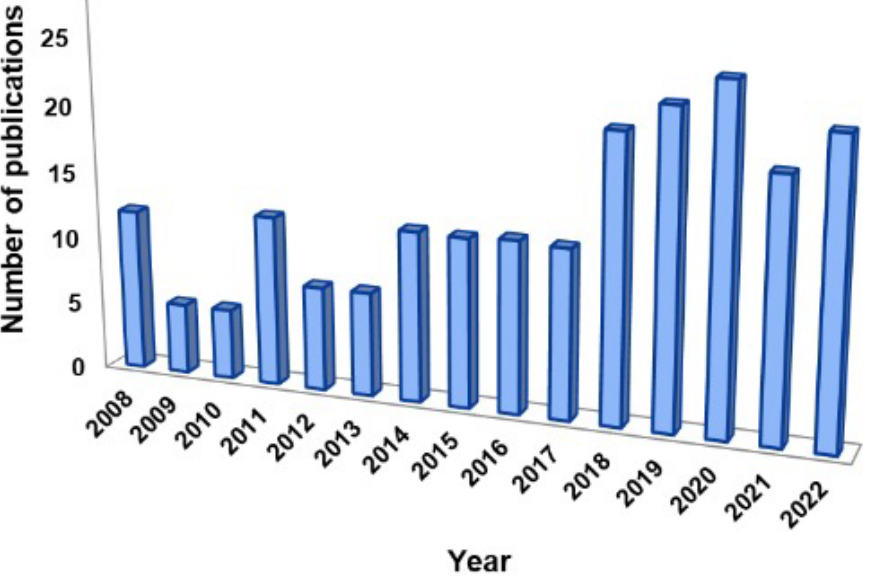
Figure 9. Development of the research field regarding dimension reduction methods for high-dimensional gene expression data.